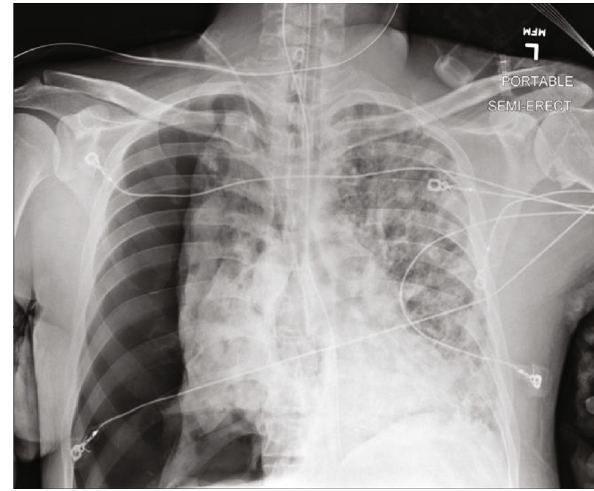
Figure 3: Initial right-sided